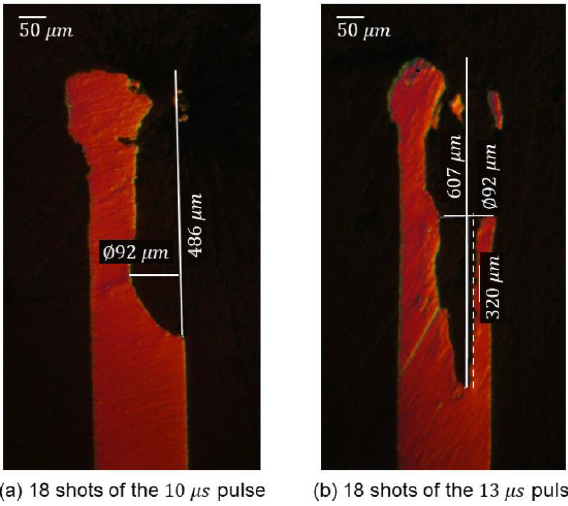
Figure 13: Microneedles drilled by 18 repetitions of the three 10 µ s pulse group and the three 13 µ s pulse